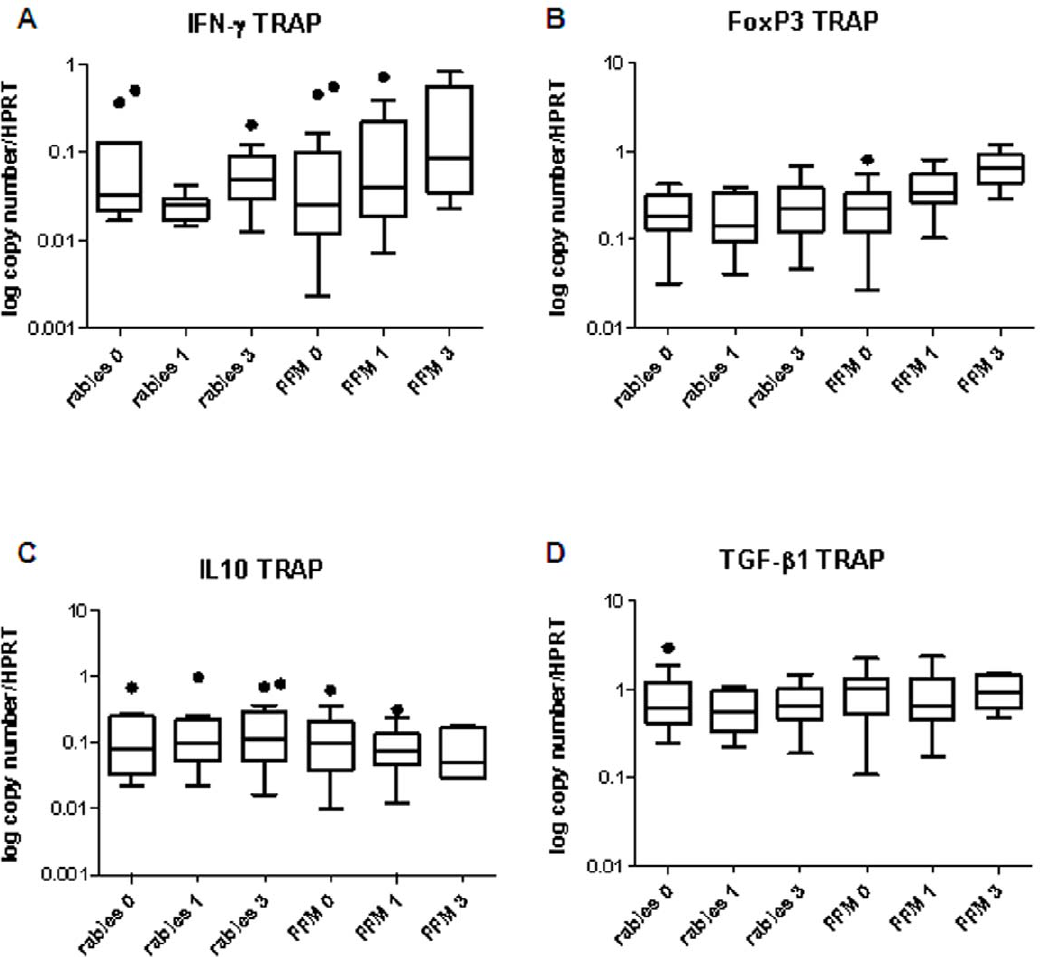
Figure 4. TRAP peptide specific IFN- c and FoxP3 mRNA expression increase in the FFM ME-TRAP vaccine group over time. A) IFN- c mRNA expression B) FoxP3 mRNA expression C) IL10 mRNA expression D) TGF- b 1 mRNA expression (n=10–20).